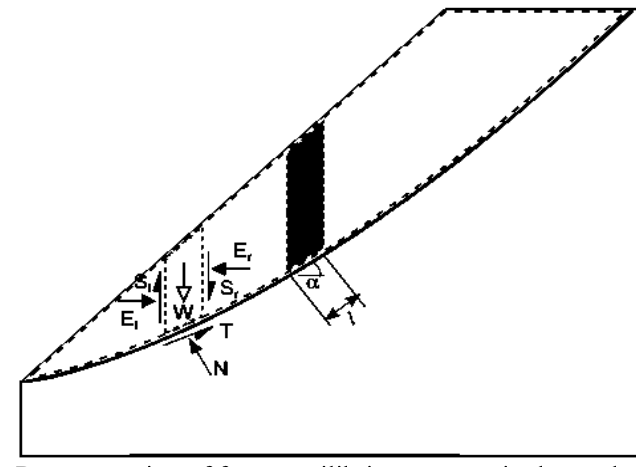
Fig. 4. Representation of force equilibrium vectors in the method